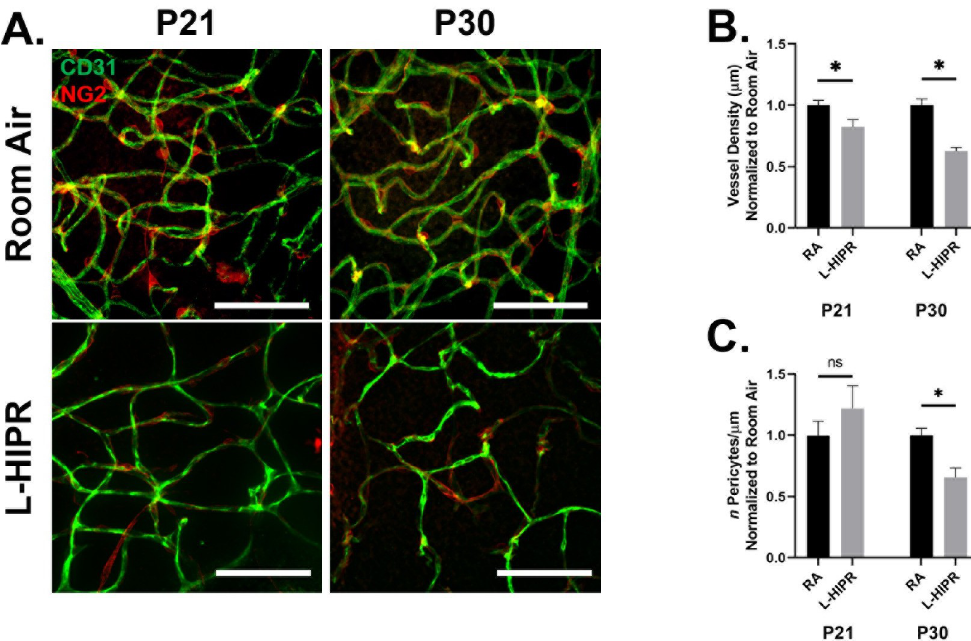
Fig 6. Lower pericyte count is observed in L-HIPR. (A) Immunolabeled retinal flat-mounts at P21 and P30 of room air and L-HIPR tissue. Blood vessels were labeled with anti-CD31 (green), and pericytes with NG2 (red). Scale bars equal 50 μ m. (B) Graphical representation of vessel density where CD31 vessel length after skeletonization was quantified against image area and normalized to room air values. At both time points the L-HIPR vascular density was significantly less dense. (C) Graphical representation of NG2 + pericyte counts per micron of CD31 vessel length ( μ m) normalized to room air values. There was not a statistically significant difference in pericyte counts between room air and L-HIPR at P21, however, there was a significant reduction at